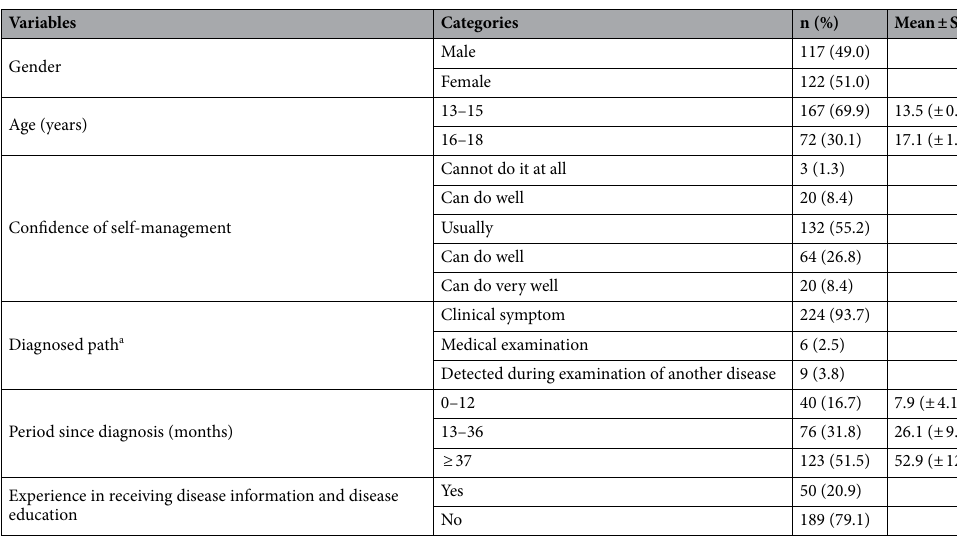
Table 1. Participant characteristics (N = 239). a Confirmed as having moyamoya disease.